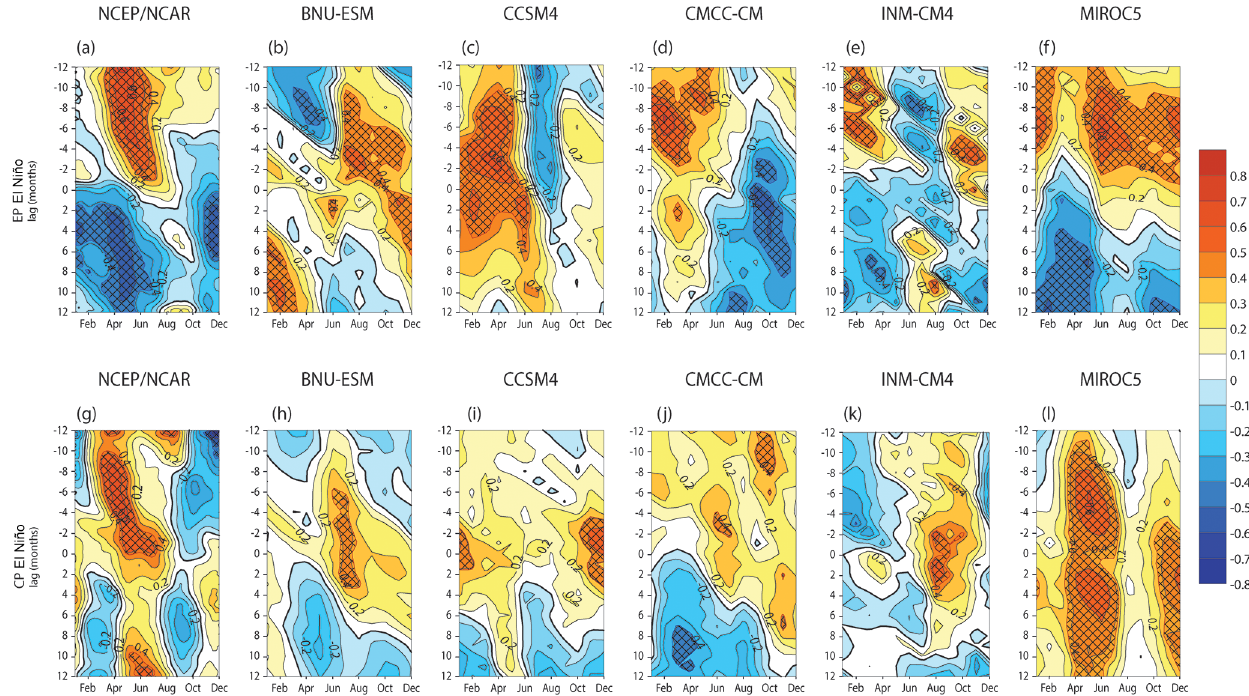
Figure 10. Monthly lagged correlation of E (a–f) and C (g–l) indices as a function of start month with respect to MJO activity index for NCEP/NCAR Reanalysis and five CMIP5 models. Contour interval is 0.1. Negative correlation is blue shaded, positive correlation is orange shaded. Hatching lines denote correlation at the 90% statistical confidence level based on Gaussian statistics. The thick black line indicates the zero correlation line.